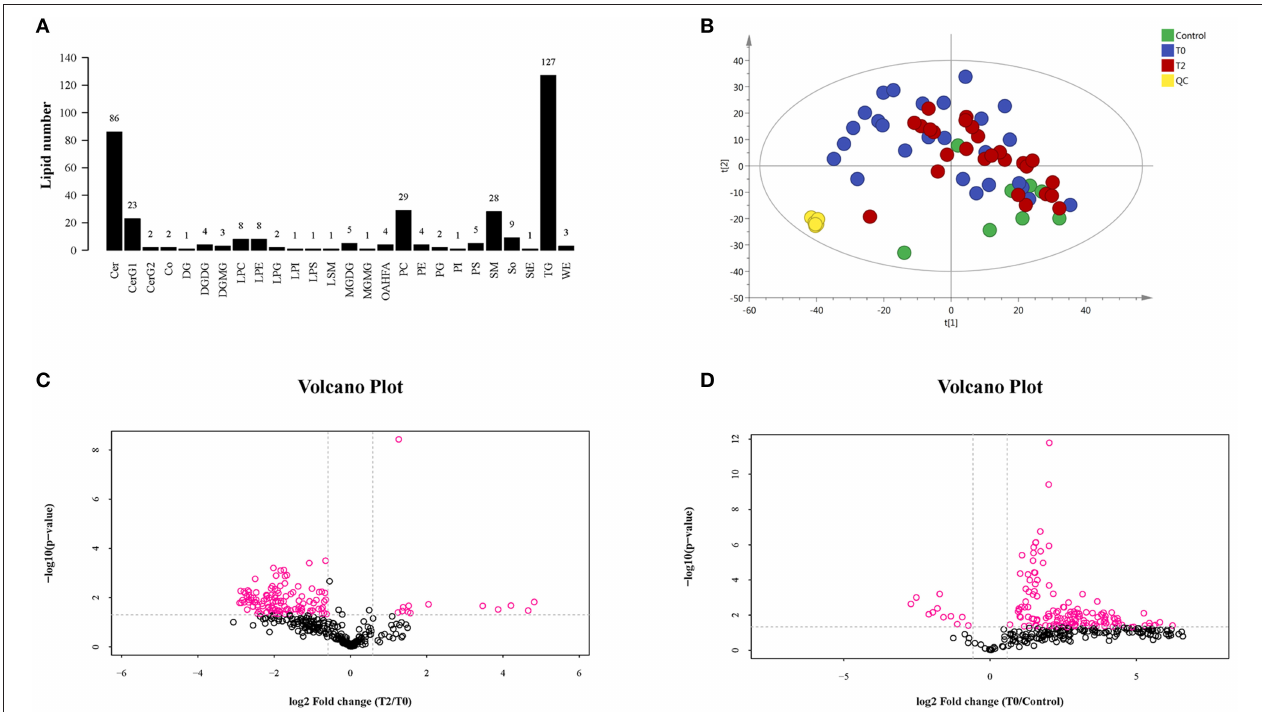
FIGURE 2 | The LC-MS/MS analysis of human meibum in normal control ( n = 10), before the first treatment of IPL (T0, n = 26) and the third treatment (T2, n = 26). (A) The identification of the lipid species. (B) PCA diagram among T0 group, T2 group, control group, and QC group. There was a significant trend distinction between T0 and control groups. (C,D) , respectively). The volcano plot of the lipids’ quality of T2 vs. T0 (C) and T0 vs. control (D) .